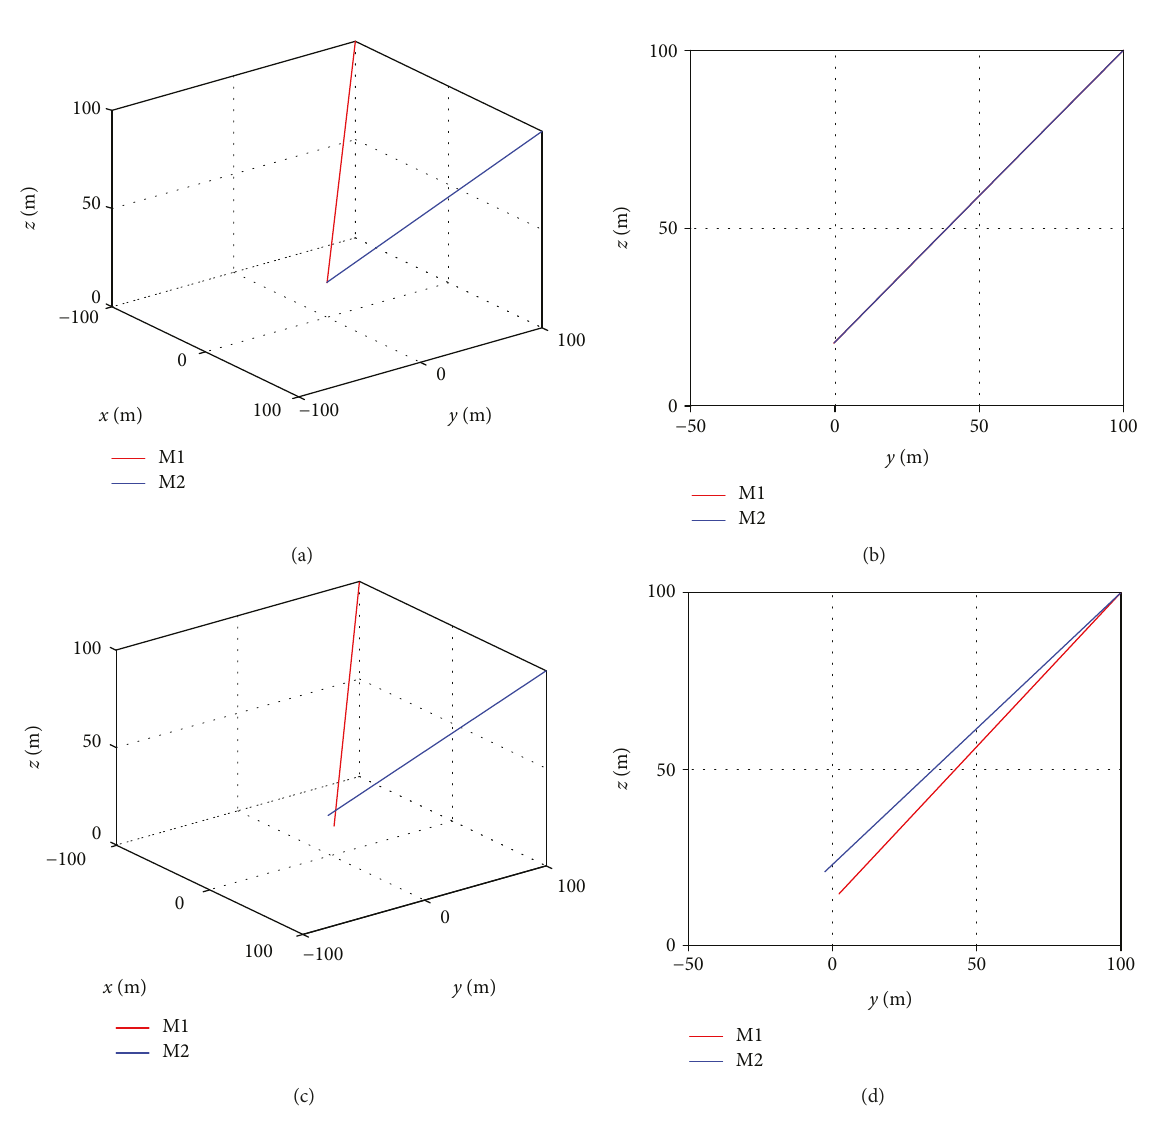
Figure 4: Simulation results of collision avoidance strategy. Table 2: Initial conditions of the missile